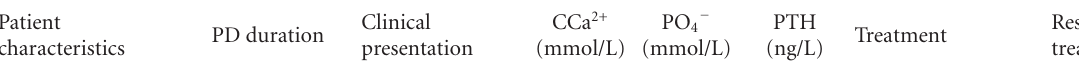
Table 2: CUA cases within our local PD